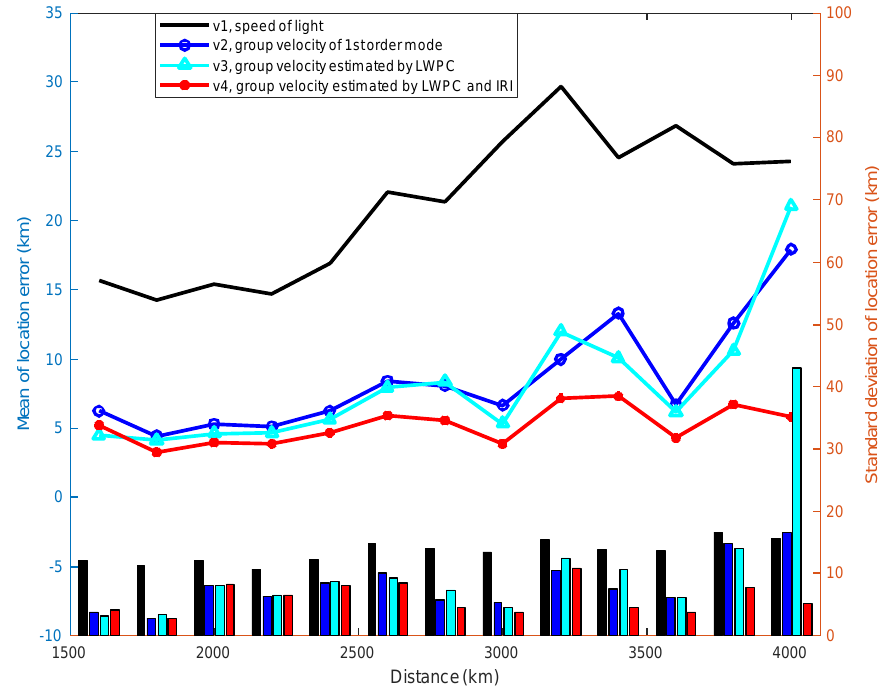
Figure 9. The relation of lighting location errors with the distance from lightning events to ELLN. The comparison is made among different methods of group velocity estimation using lightning location results in the time of day–night transition. The curves are the mean values, and the bar graphs are the standard deviations, which correspond to the left and right y-axes respectively.